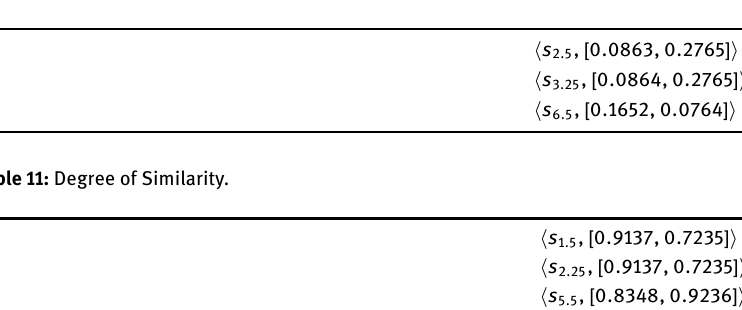
Table 10: Comprehensive Evaluation Values.